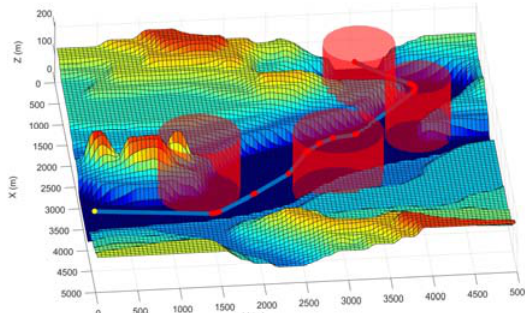
Fig. 6. UAV trajectory computed by the FPA for the river map (synthetic map, 25 km 2 , terrain elevation from 0 to 217 m